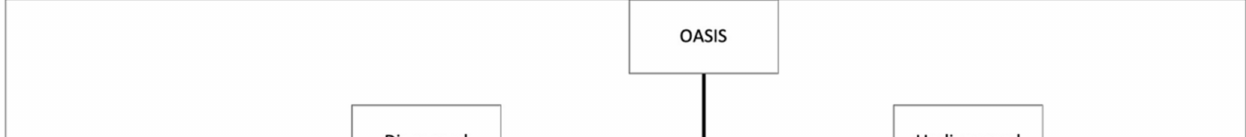
Figure 5. Proposed algorithm for the management of OASIS. OASIS: obstetric anal sphincter injuries. FI: fecal incontinence. PFPT: pelvic floor physical therapy. SNM: sacral nerve